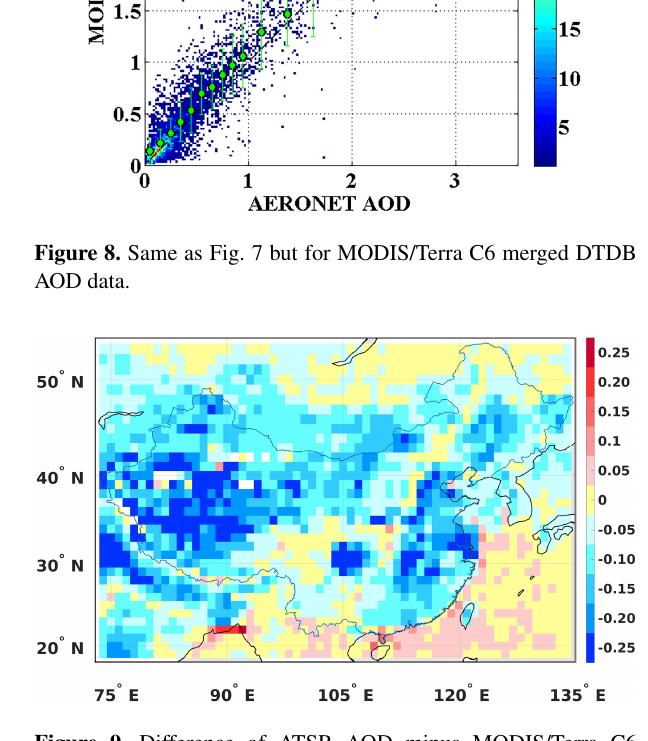
Figure 9. Difference of ATSR AOD minus MODIS/Terra C6 merged DTDB AOD, aggregated for the years 2000–2011, over China. The values in increments of 0.05 are given in the color scale to the